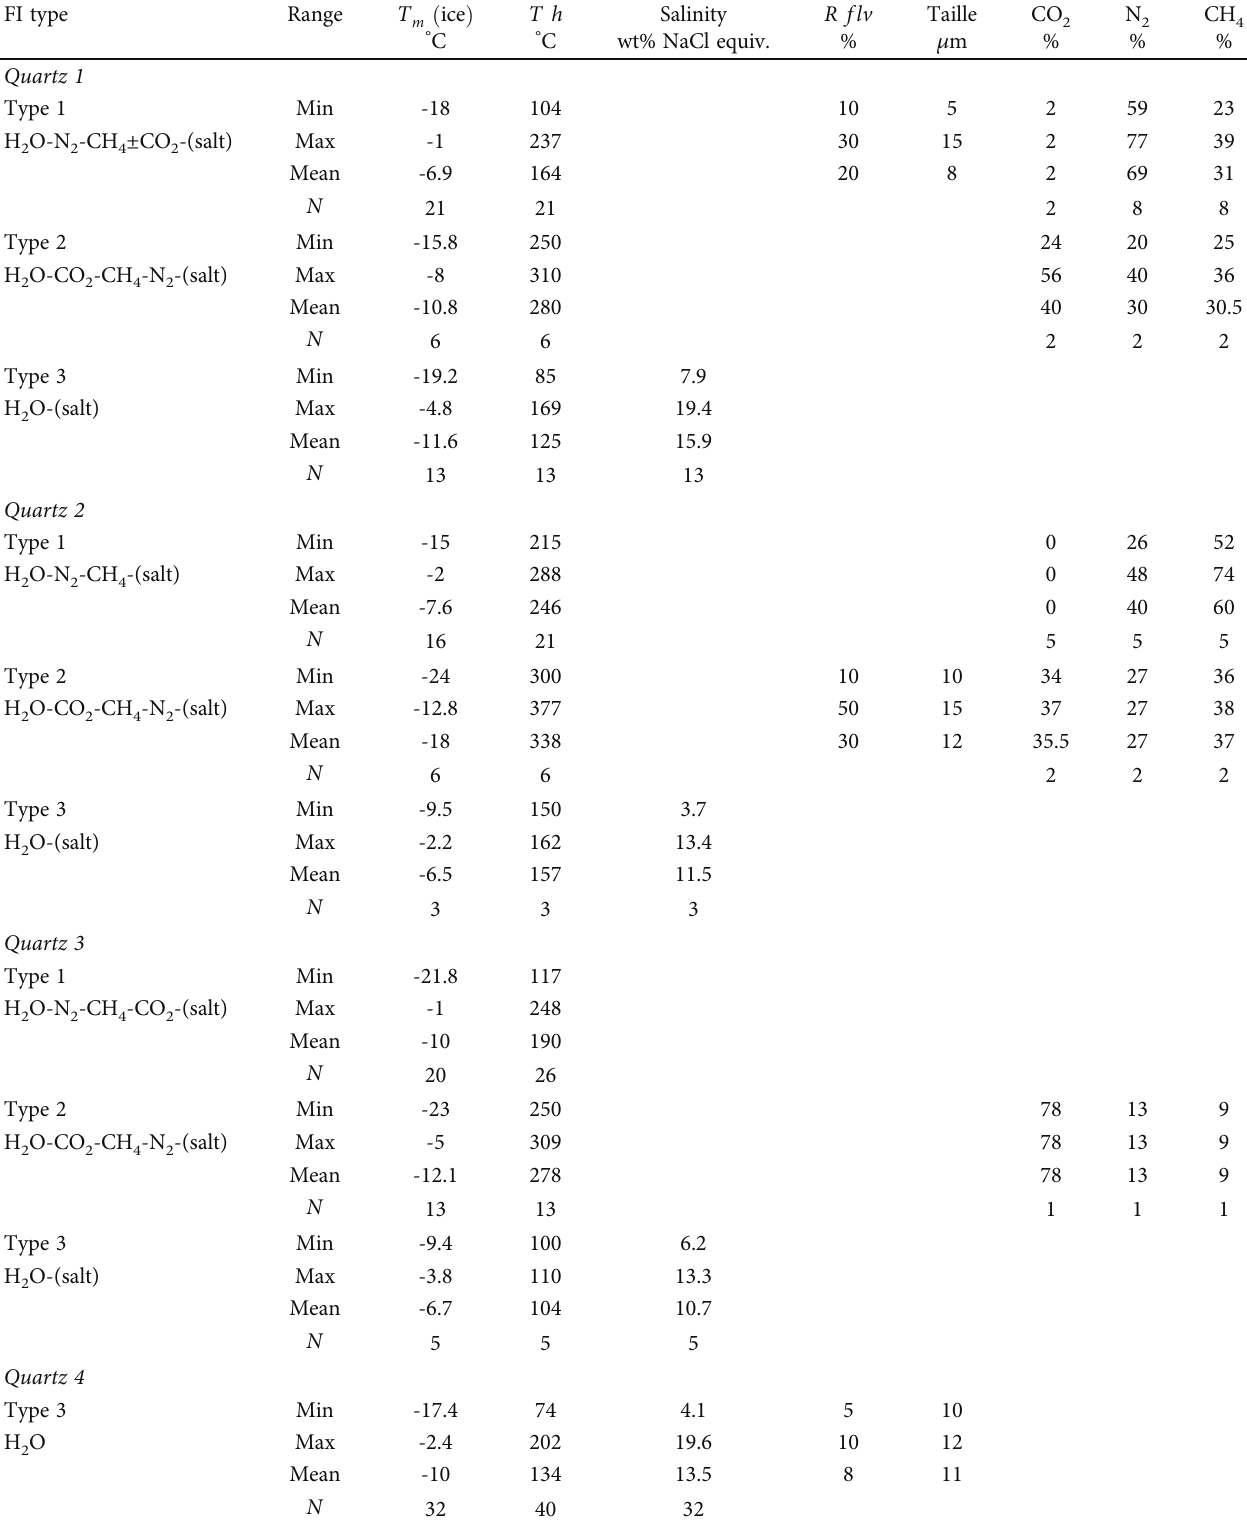
Table 3: Summary of microthermometric and Raman microspectrometric data of fl uid inclusions in mineralised veins of the Roc Blanc Ag- Pb-Zn deposit.